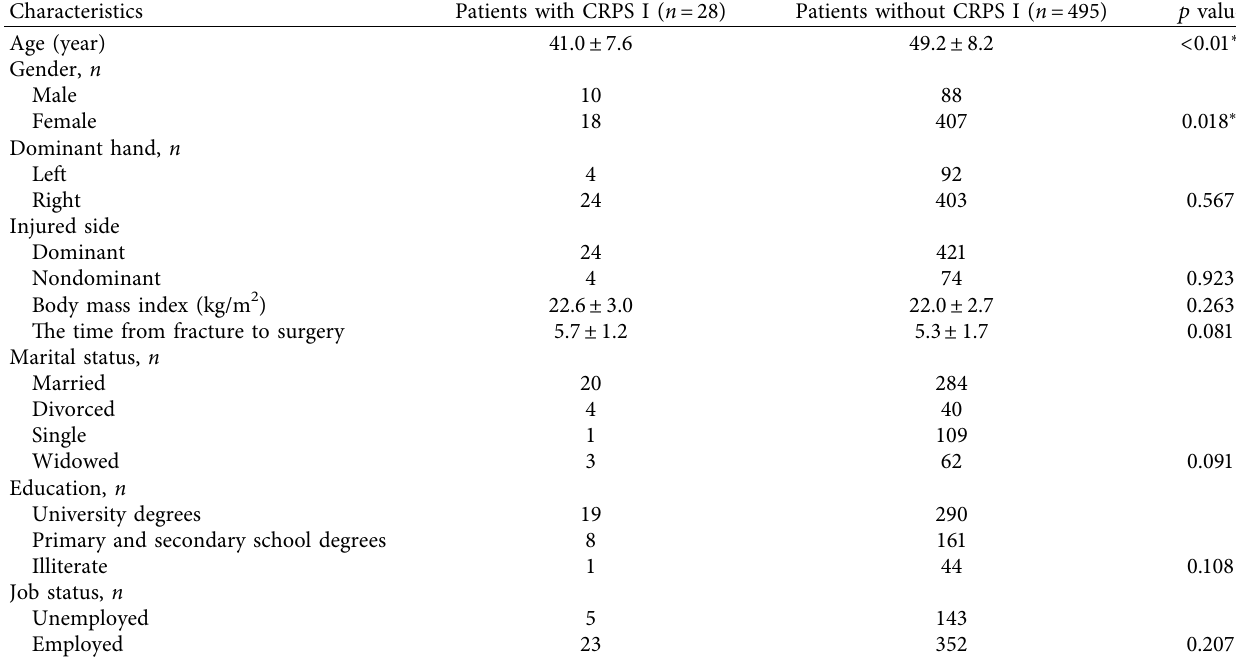
Table 3: Demographic characteristics of study